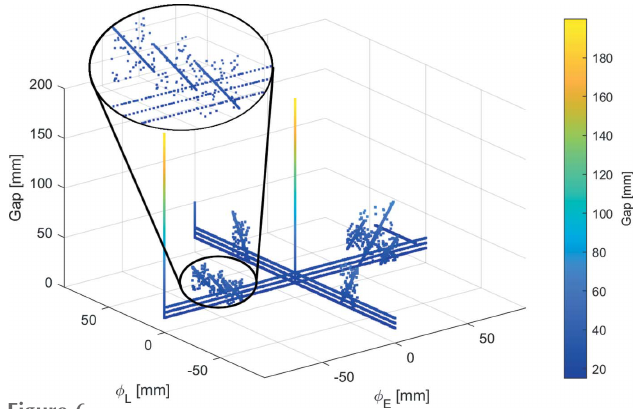
Figure 6 Distribution of 4175 simulated cases covering the operating modes of the EPU. A zoomed-in portion of the figure is provided for clarifying that the apparent ‘lines’ on the figure are composed of individual cases.